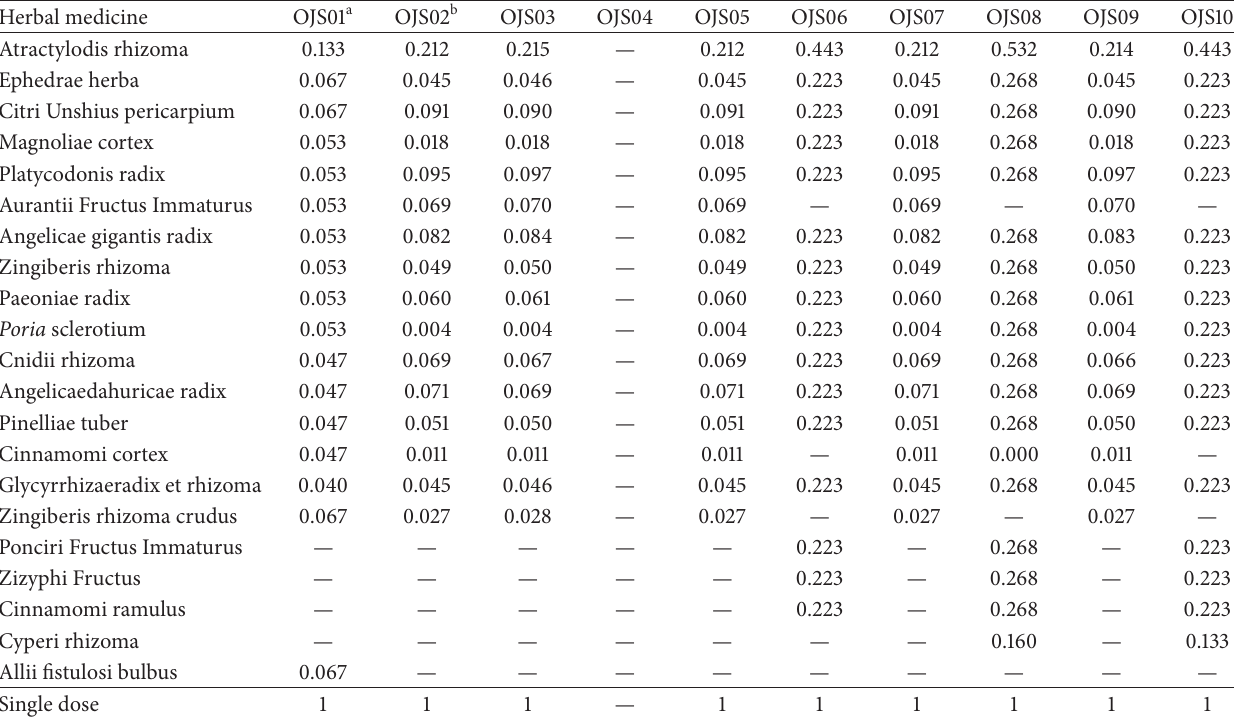
Table 1: Compositional ratio of herbal medicine consisting of Ojeok-san (OJS)